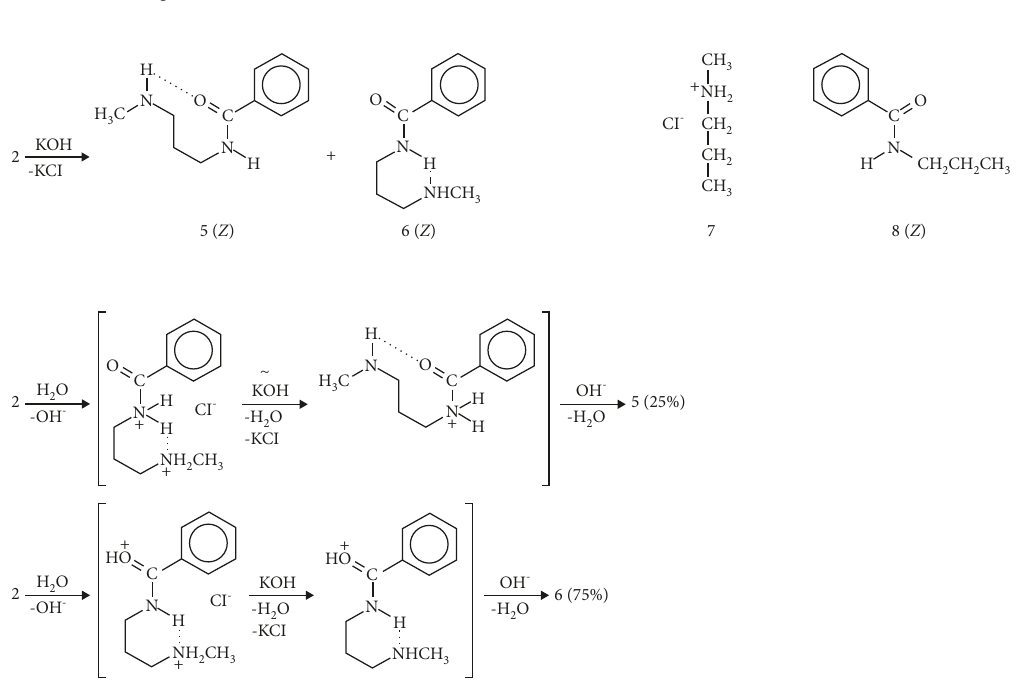
Scheme 4: Conformational isomers 5-6 upon deprotonation regulated by two mechanisms and reference compounds 7-8 . The carbamoyl oxygen atom initial protonation is efficient and increases the secondary amide stabilization energy in general; whereas, the nitrogen atom protonation has the capability for conformational change ( ∼ ) as a result of repulsive orbital-orbital interactions in the less stable tetrahedral intermediate (see steps in the migration course upon activation by water). The intramolecular rearrangement step occurs with retention of the stereochemistry at the migrating center under the reaction